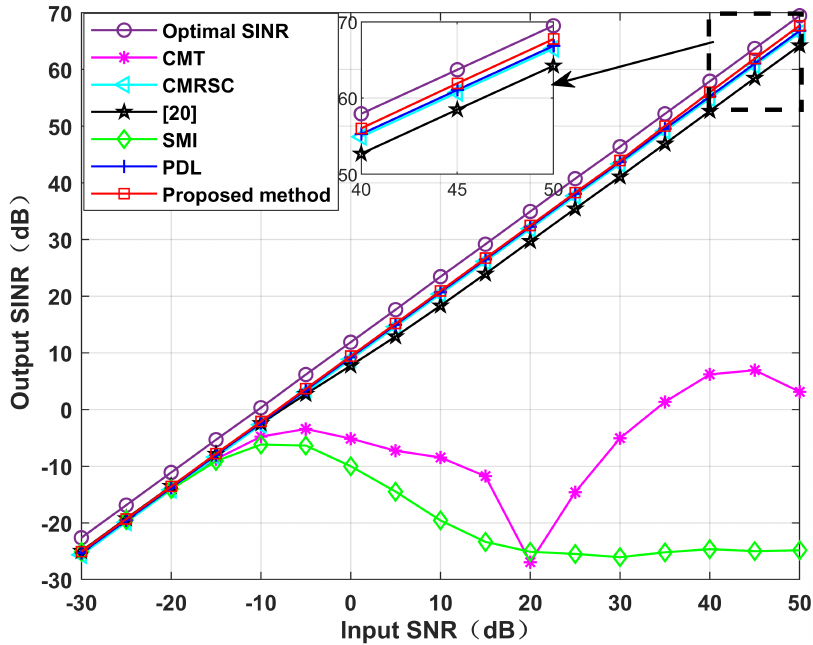
Figure 14. Output SINR when there is a + 5 ◦ desired signal SV mismatch. Simulation 6.